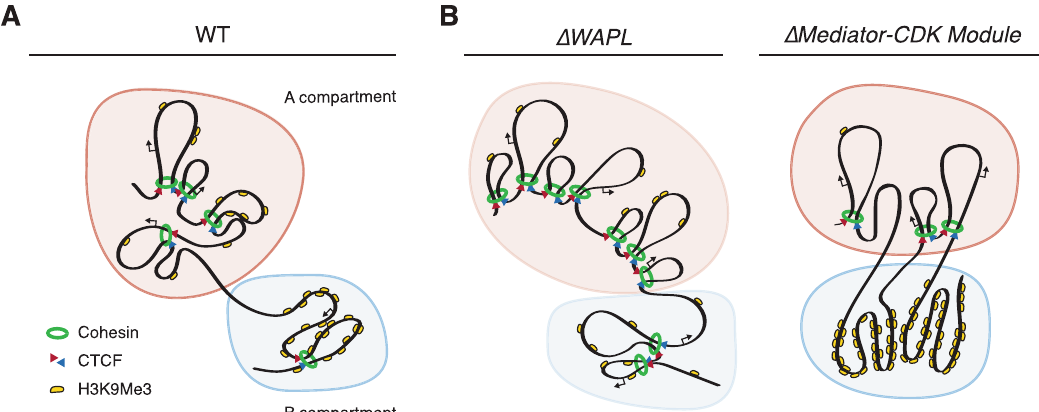
Fig. 6 The Mediator CDK Module and cohesin play distinct and opposite roles in the genomic distribution of heterochromatin. A Heterochromatin domains, marked by H3K9me3, cluster together in three-dimensional space, separating the genome in A- and B compartments. B Model for how cohesin and Mediator-CDK may play opposite roles in heterochromatin domain formation. Upon loss of the cohesin-release factor WAPL and stabilization of cohesin, loops increase in size, leading to a loss of compartmentalization. This perturbs the formation and spreading of heterochromatin domains. Loss of members of the Mediator-CDK-Module results in unconstrained heterochromatin-domain ampli fi cation and hyper-compartmentalization, impairing cohesin- and CTCF binding and a loss of associated